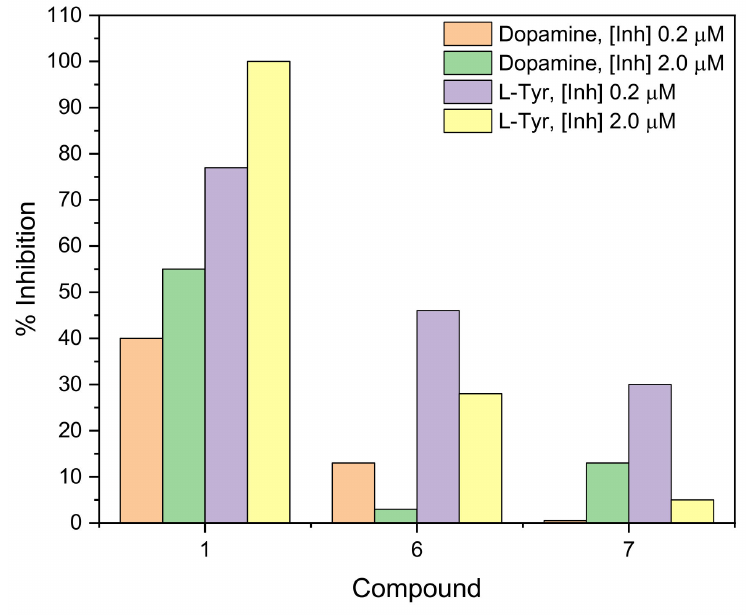
Figure 4. Percentage of tyrosinase inhibition determined by UV-Vis spectroscopy using either L- Tyrosine or dopamine at 0.2 and 2.0 µ M as substrate.